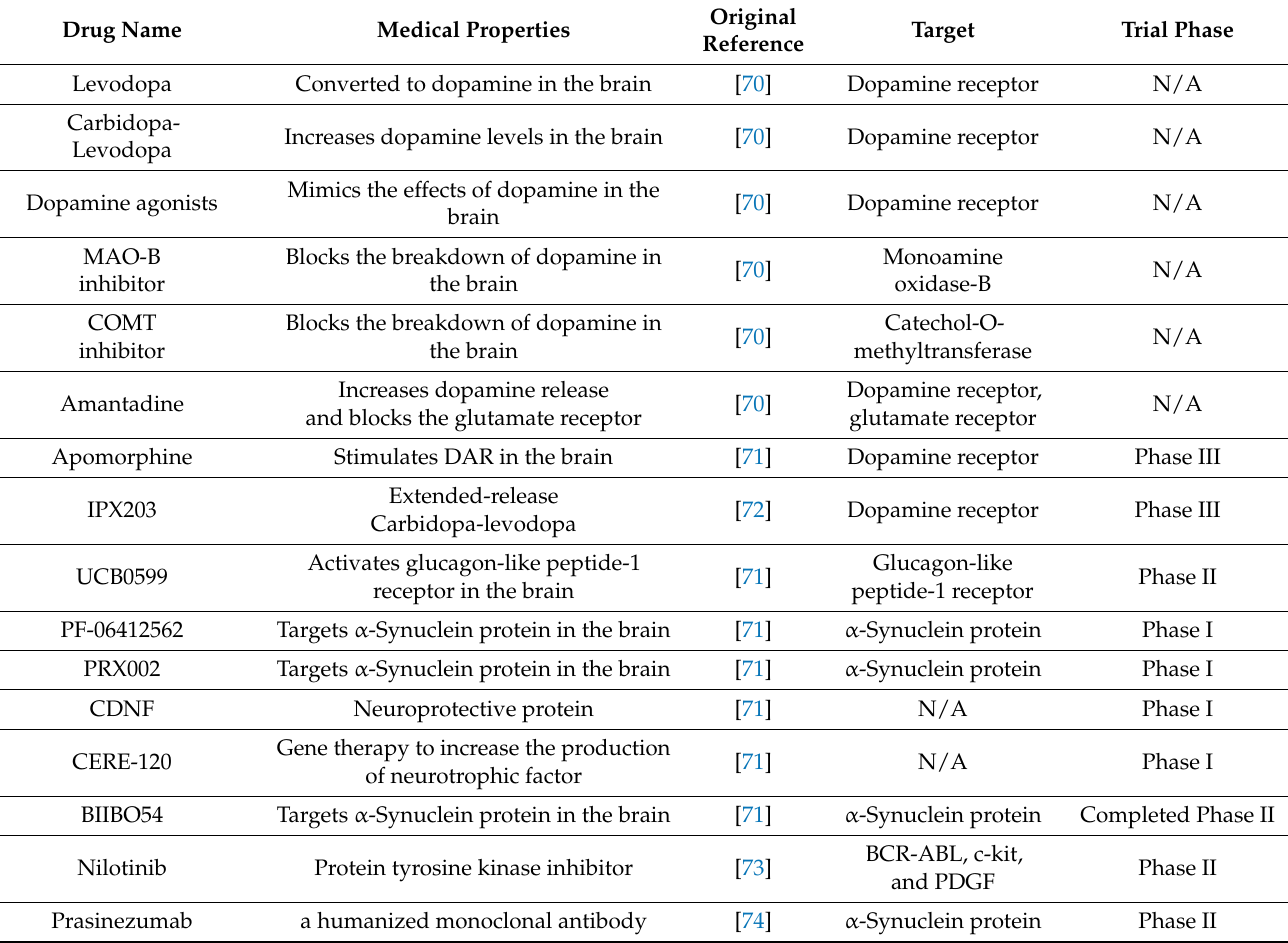
Table 1. PD drugs, medicine properties, original references, target, trial